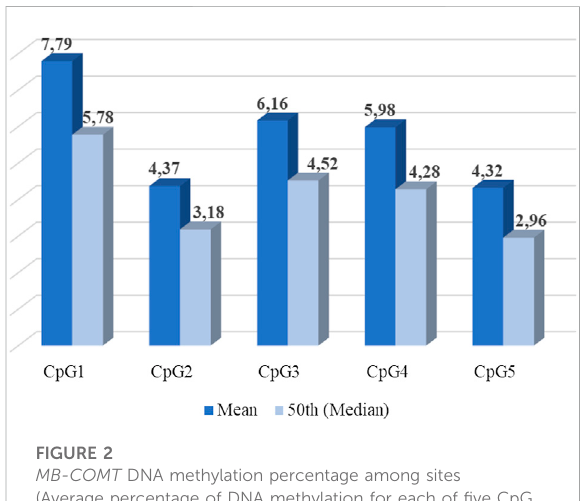
FIGURE 2 MB-COMT DNA methylation percentage among sites (Average percentage of DNA methylation for each of fi ve CpG sites-mean and median).